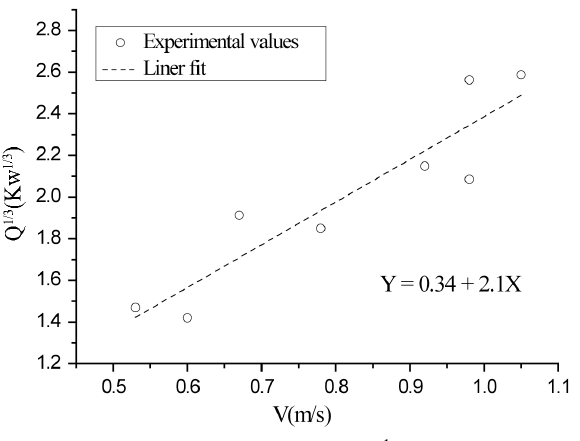
Fig. 13. The relationship between V